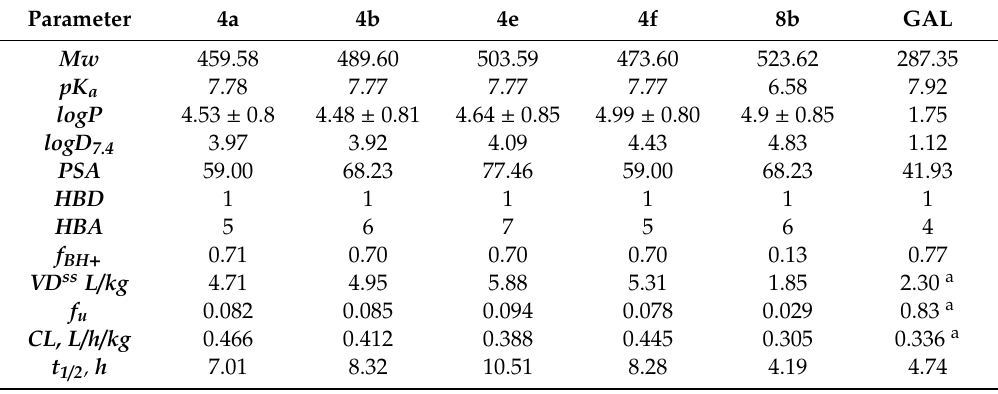
Table 2. Physicochemical properties and PK parameters of the active GAL-CU hybrids.